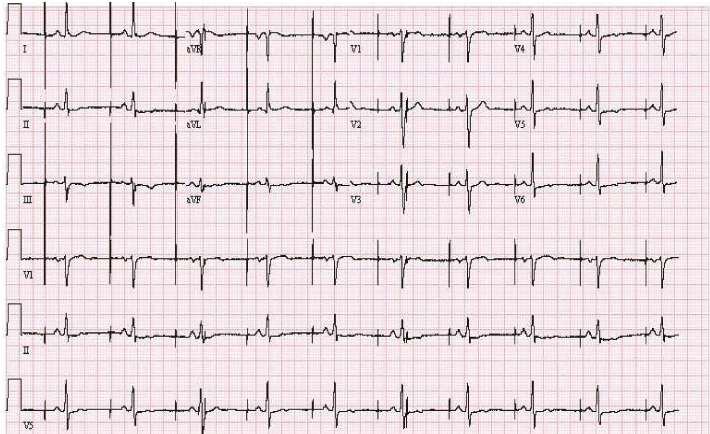
Figure 1: 12-lead ECG showed normal sinus rhythm with loss of capture of atrial